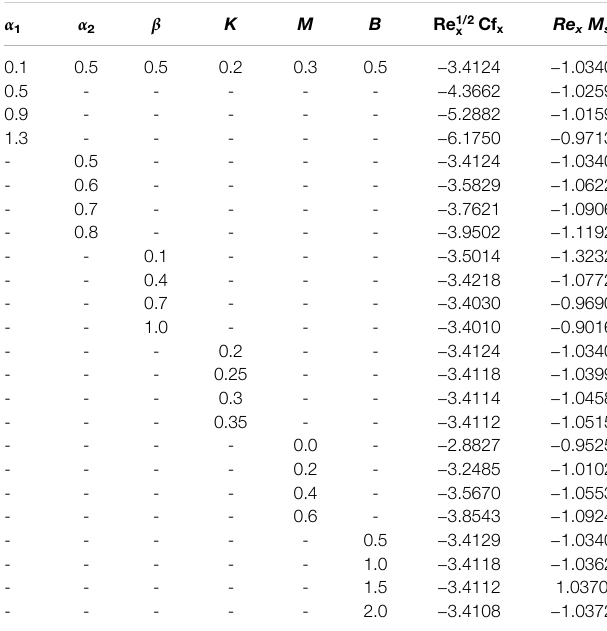
TABLE 3 | Numerical fi ndings of R e x M s and Re 1 / 2 x Cf x for various values of parameters